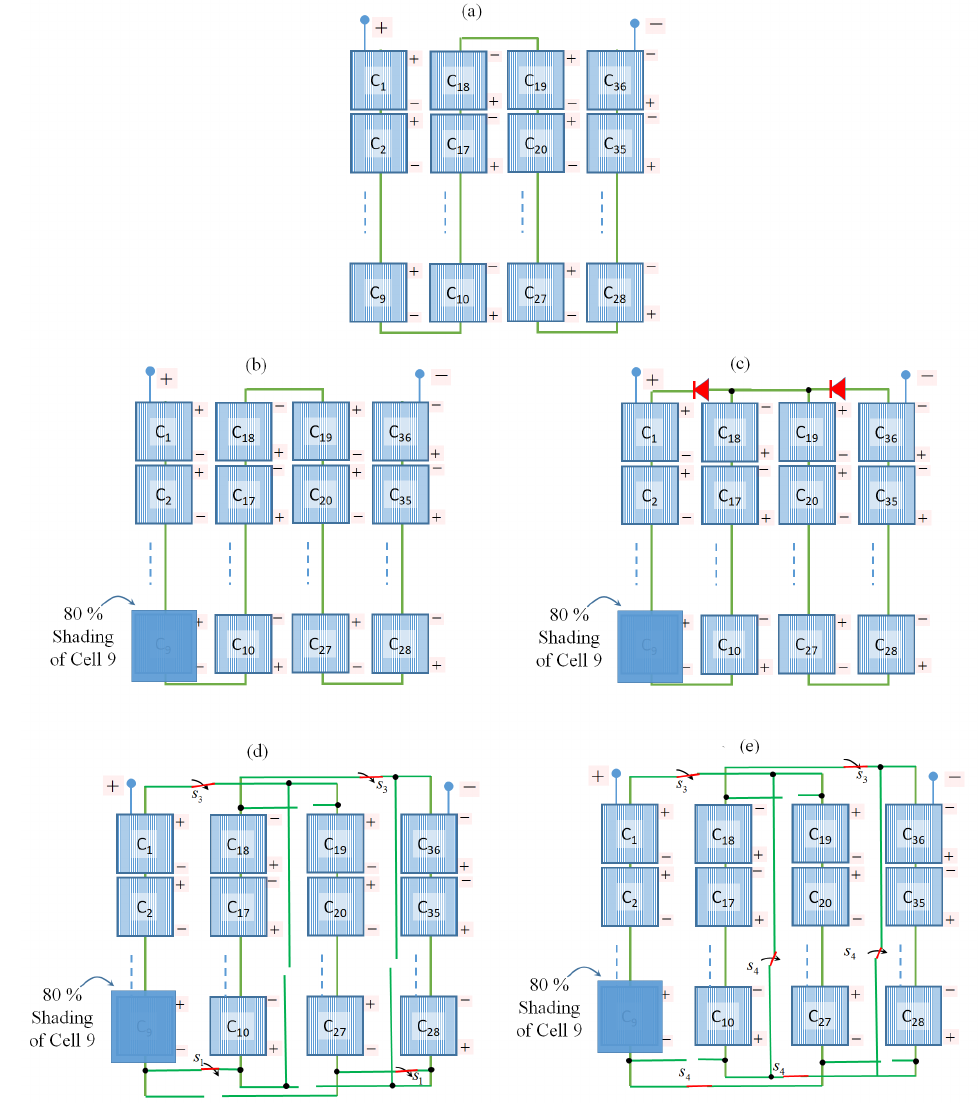
Figure 5. Five cases for the PV module ( a ) Conventional module without shading; ( b ) conventional module with shading; ( c ) mode 1: the same cell is shaded in the presence of two bypass diodes; ( d ) mode 2: the same cell is shaded without bypass diodes; ( e ) mode 3: the same cell is shaded without bypass